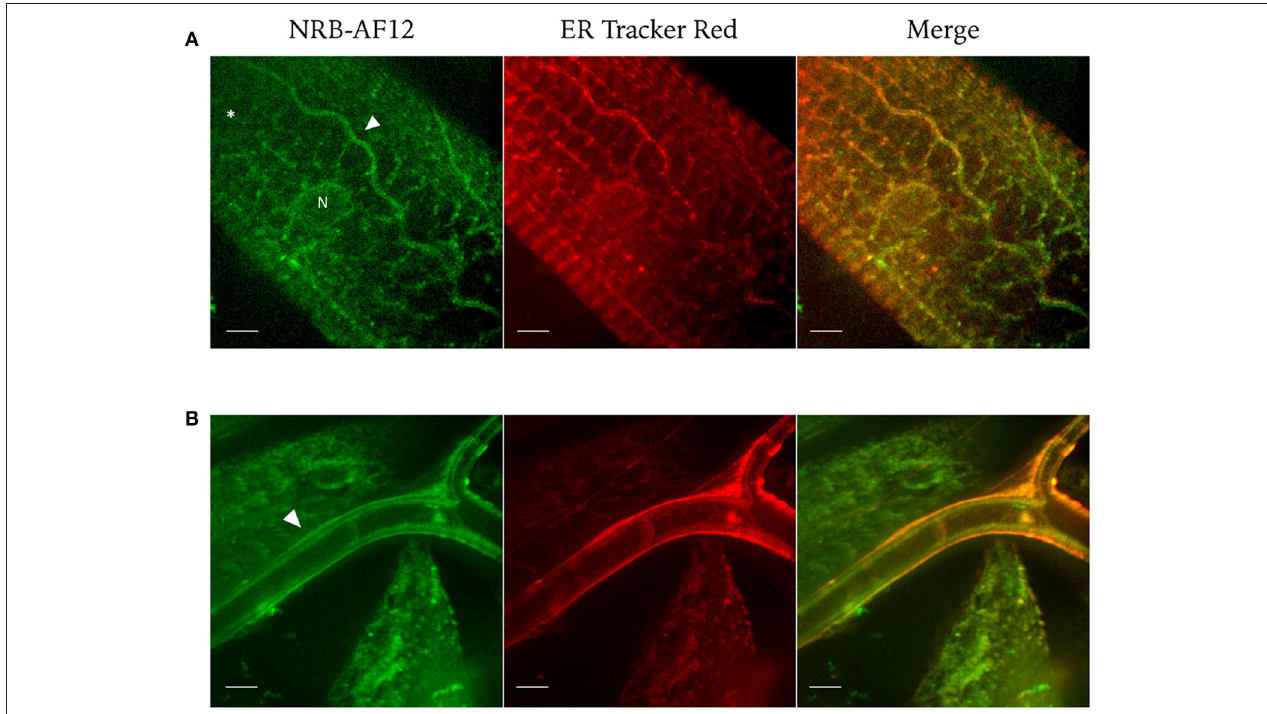
FIGURE 9 | Confocal live imaging of Drosophila (A) muscles and (B) tracheal system labeled with NRB-AF12 (green) and ER-Tr red (red). Both fluorescent dyes, added to the dissected larva in HL3 physiological solution, show an overlapping pattern of distribution as highlight by the yellow signal of the merged images (*: muscle; white arrowhead: trachea; N: nucleus). Magnification 60x; scale bar 10 µ m.